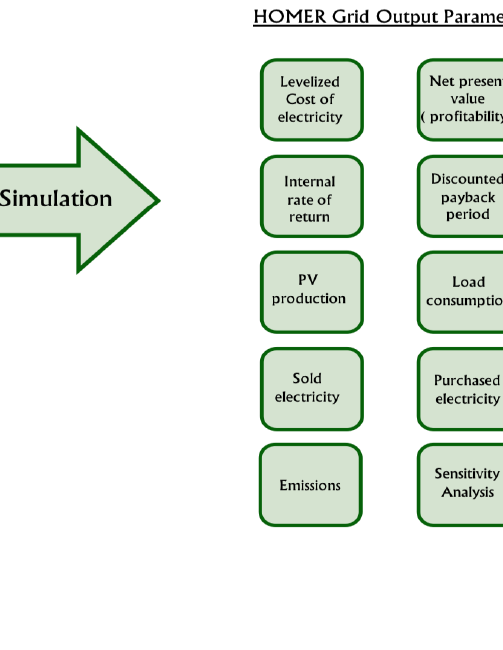
Figure 2. HOMER Grid Schematic Diagram.